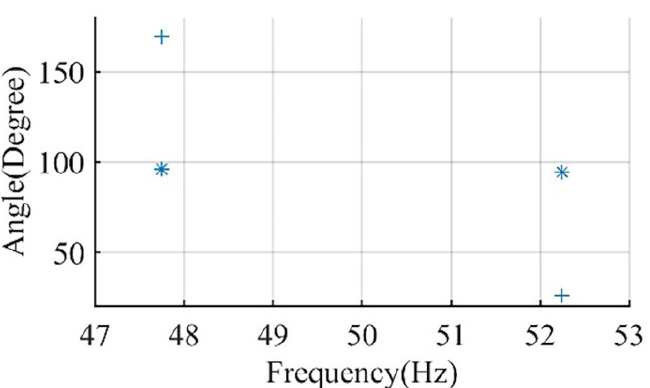
Figure 5. Motor II phase angle of left sideband and right sideband components for healthy conditions at; inertia of 16.84 kg·m 2 (+), and inertia of 0.041 kg·m 2 (*).